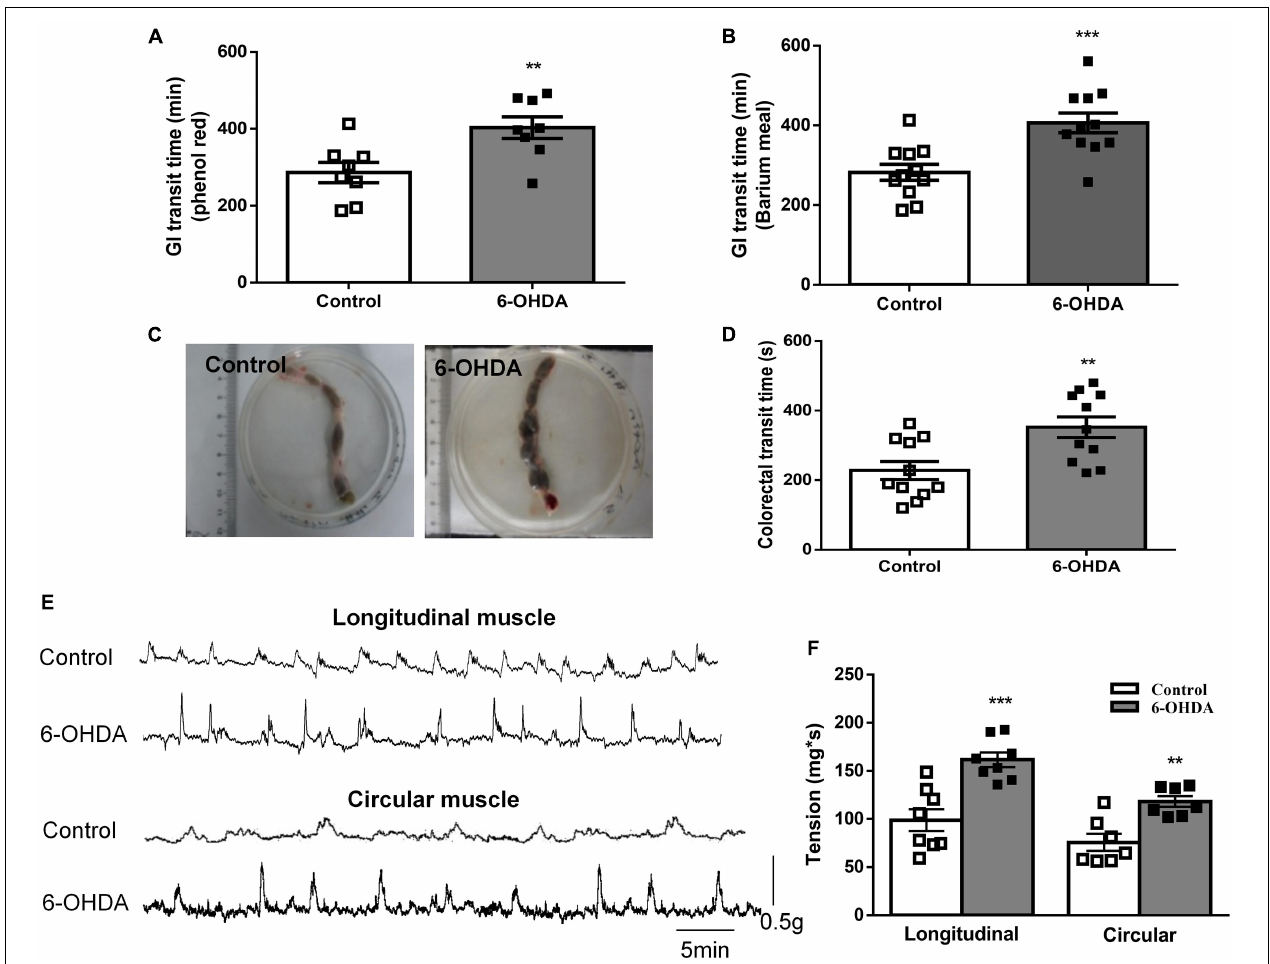
FIGURE 1 | Outlet obstruction constipation in 6-OHDA rats. (A) Whole GI transit time of phenol red ( n = 8). (B) Whole GI transit time of barium meal ( n = 11). (C) Fecal retention in the colorectum of 6-OHDA rats. (D) Colorectal transit time using a bead expulsion test ( n = 11). (E) Representative tracings of the colorectal spontaneous contraction of control and 6-OHDA rats. (F) Bar charts show the contractive tension of colorectum ( n = 8). ** P < 0.01, *** P <